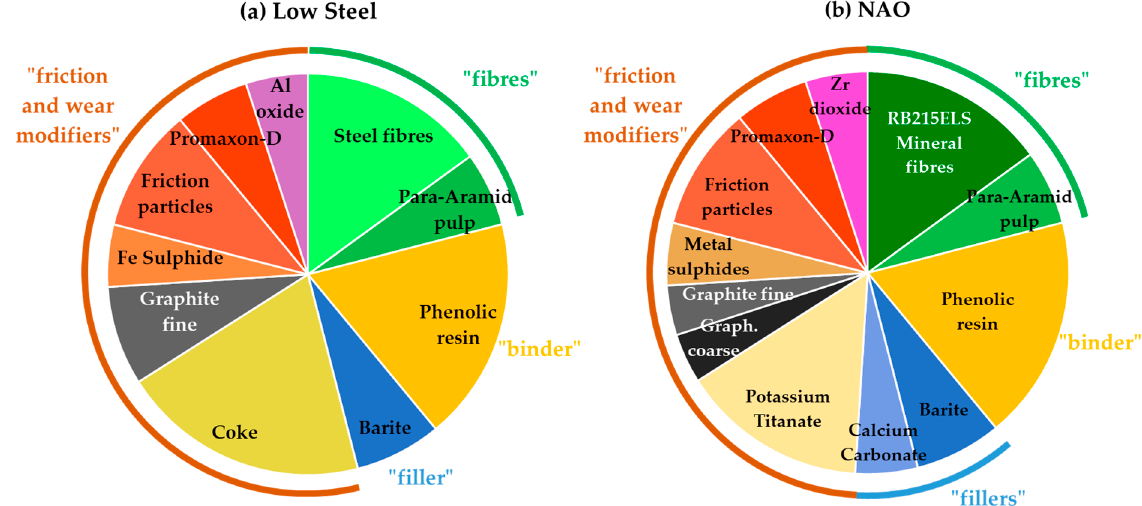
Figure 1. Composition of the two formulations in volume fraction: ( a ) LS formulation; ( b ) NAO formulation.